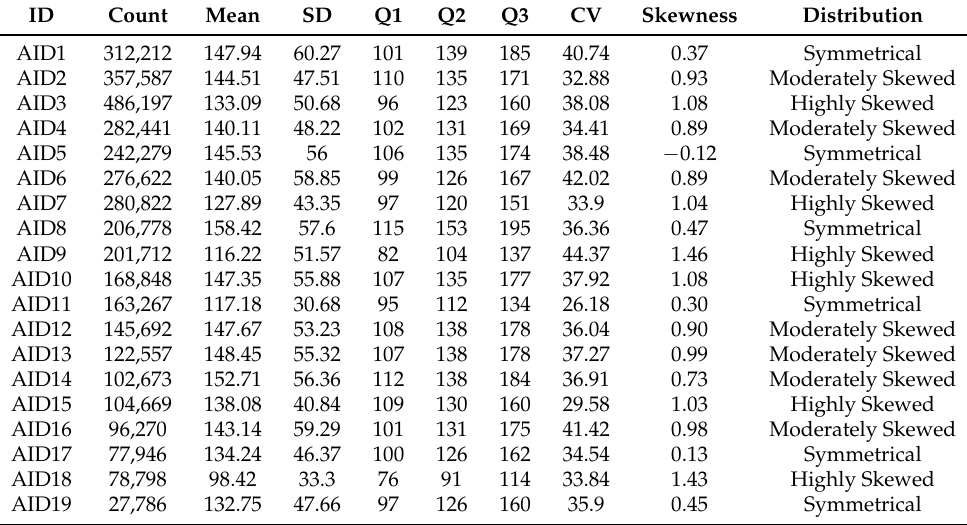
Table 4. Descriptive statistics for complete glucose profiles of selected AID users. Abbreviations: Count, count of glucose data points; SD, standard deviation; Q1/Q2/Q3, first/second/third quantile; CV, coefficient of